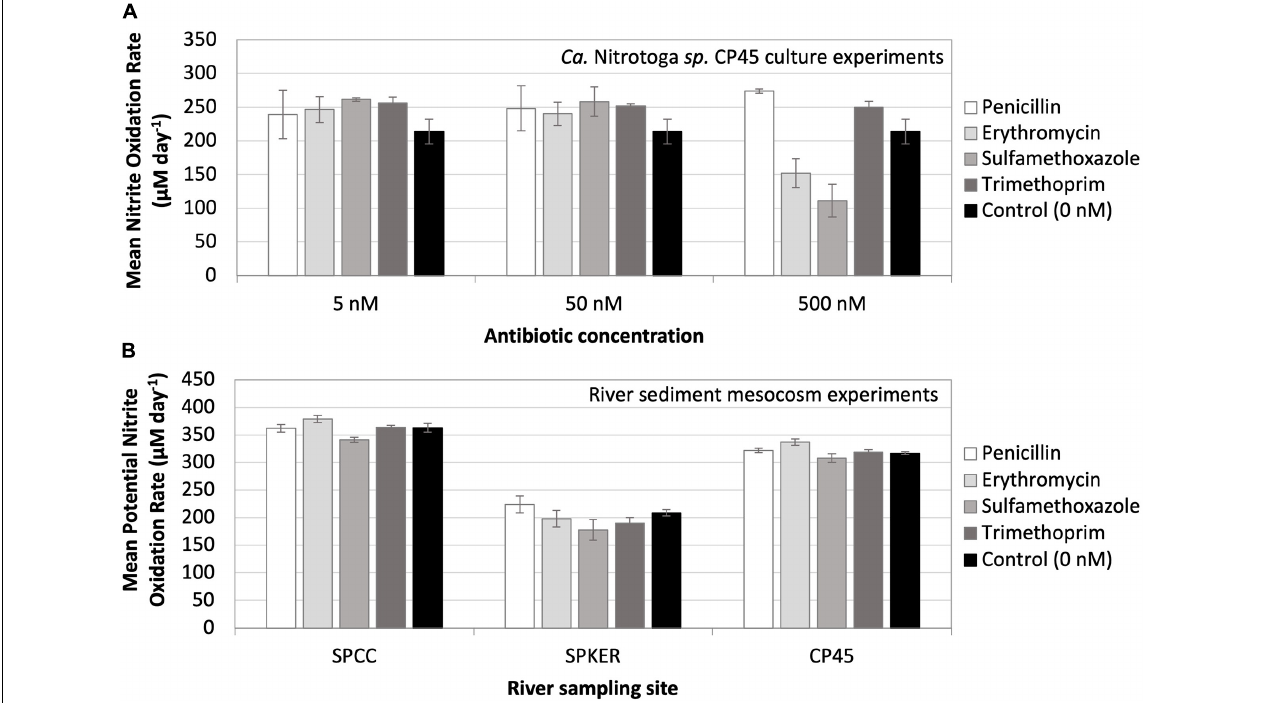
FIGURE 4 | (A) Mean nitrite oxidation rates ( µ M day – 1 ) by Ca . Nitrotoga sp. CP45 in the presence of 5, 50, and 500 nM concentrations of four different antibiotics (penicillin, erythromycin, sulfamethoxazole, and trimethoprim). Controls contained no antibiotics. (B) Mean potential nitrite oxidation rates ( µ M day – 1 ) from river mesocosm experiments where sediments from three river sites (SPCC, SPKER, and CP45) were exposed to four antibiotics (penicillin, erythromycin, sulfamethoxazole, and trimethoprim) at a concentration of 500 nM. Antibiotic-free sediments were utilized to represent inherent, endogenous microbial nitrite oxidation activity at each site. Each symbol represents the average of triplicate cultures or sediment incubations grown under each condition with standard deviation error